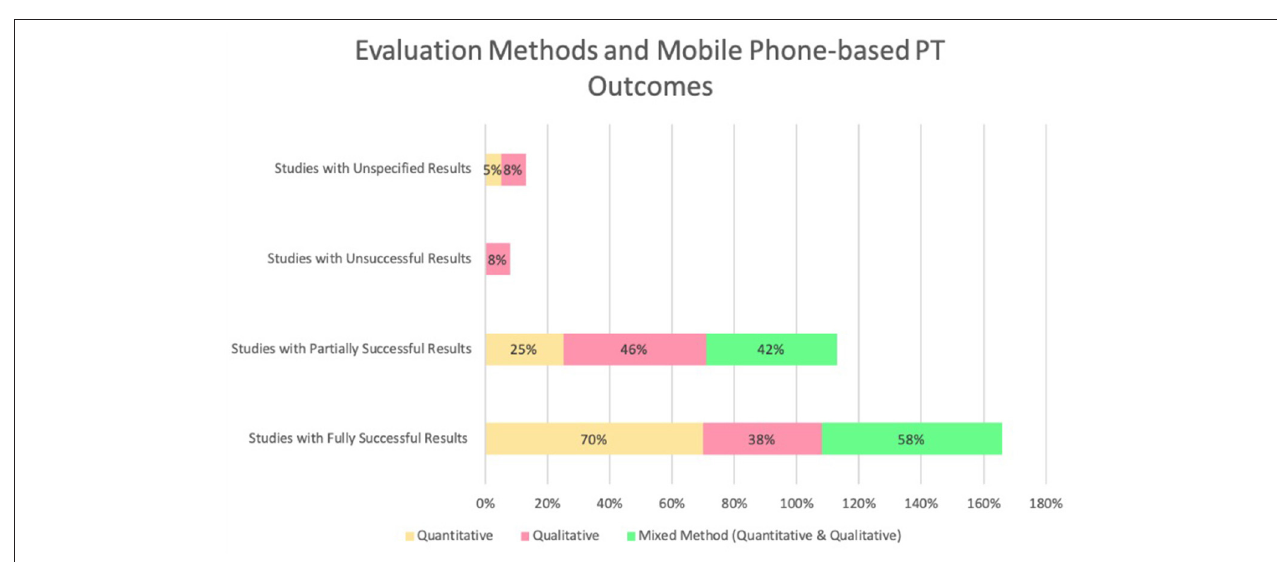
FIGURE 14 | Evaluation methods and mobile phone-based persuasive technology (PT)